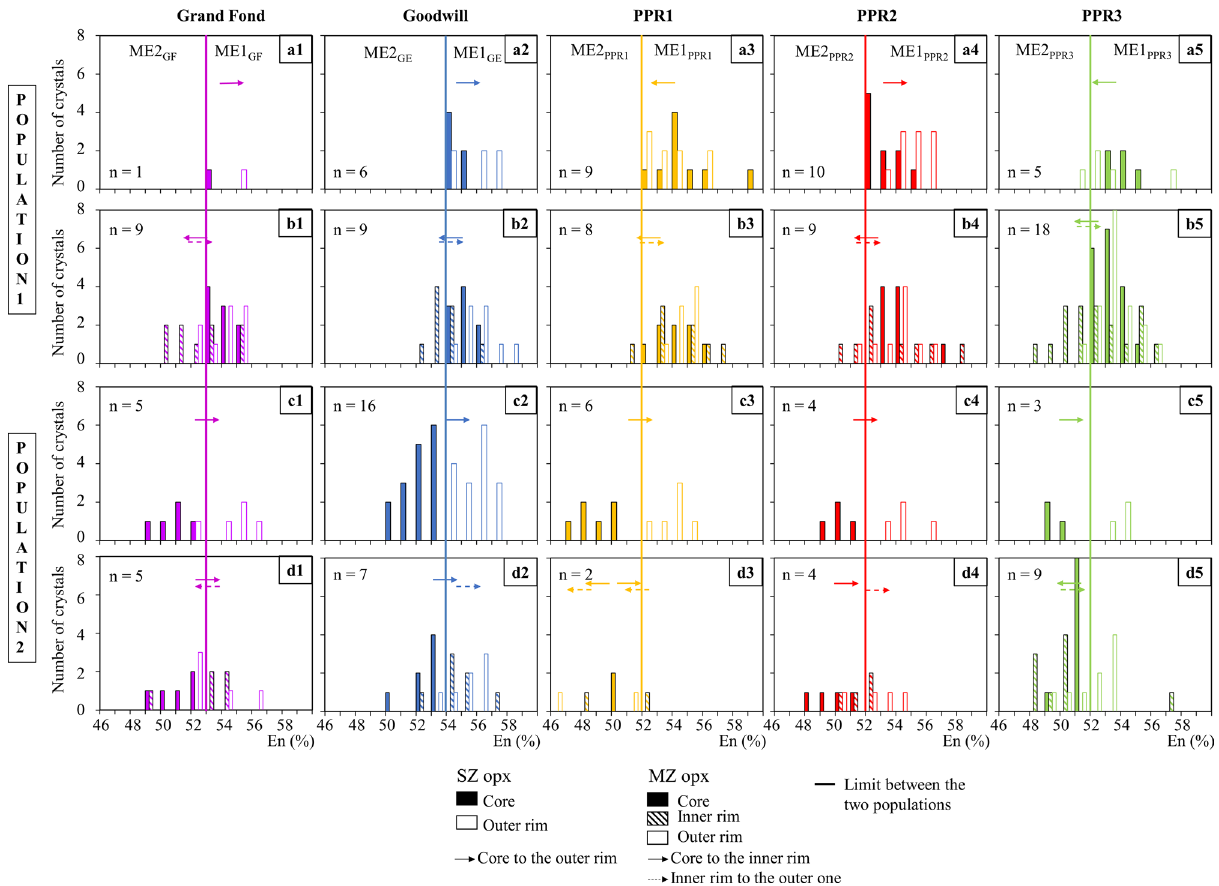
Figure 4. Frequency histograms of the En content of zoned opx of the five studied eruptions. The two populations of opx identified are the same as in Fig. 3. Population 1: cores ≥ En 53 for Grand Fond, En 54 for Goodwill and En 52 for PPR1, 2 and 3 and population 2: cores < En 53 for Grand Fond, En 54 for Goodwill and En 52 for PPR1, 2 and 3. The color for each eruption is the same as in Fig. 3. ( a1 ) to ( a5 ) single-zoned (SZ) opx of population 1; ( b1 ) to ( b5 ) multiple-zoned (MZ) opx of population 1; ( c1 ) to ( c5 ) SZ of population 2; ( d1 ) to ( d5 ) MZ of population 2. The arrows underline the major path from the core to the rim(s) recorded by the SZ opx or, for MZ, from the core to the inner rim and dashed line: inner rim to the outer one of the MZ opx. The magmatic environments (ME) discussed afterwards are specified here for each eruption. n: number of opx